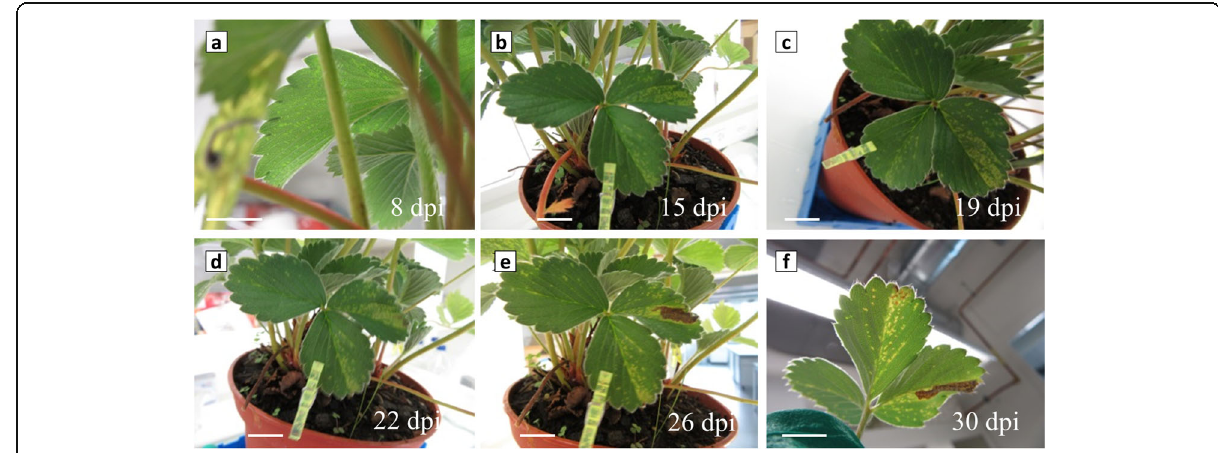
Fig. 7 Evolution of symptoms on strawberry leaves inoculated with the Xanthomonas fragariae strain JvD-0051. At 8 dpi ( a ), single spots are visible on the abaxial side of the leaf (category= 1). From 15 dpi ( b ) to 19 dpi ( c ), spots are visible on both sides of the leaf and aggregate (category= 2). At 22 dpi ( d ), spots turn to yellow color (category = 3), and then turn to extensive necrosis (category = 4) between 26 dpi ( e ) and 30 dpi ( f ), the last time point of the experiment. The white line represents 1 cm on the